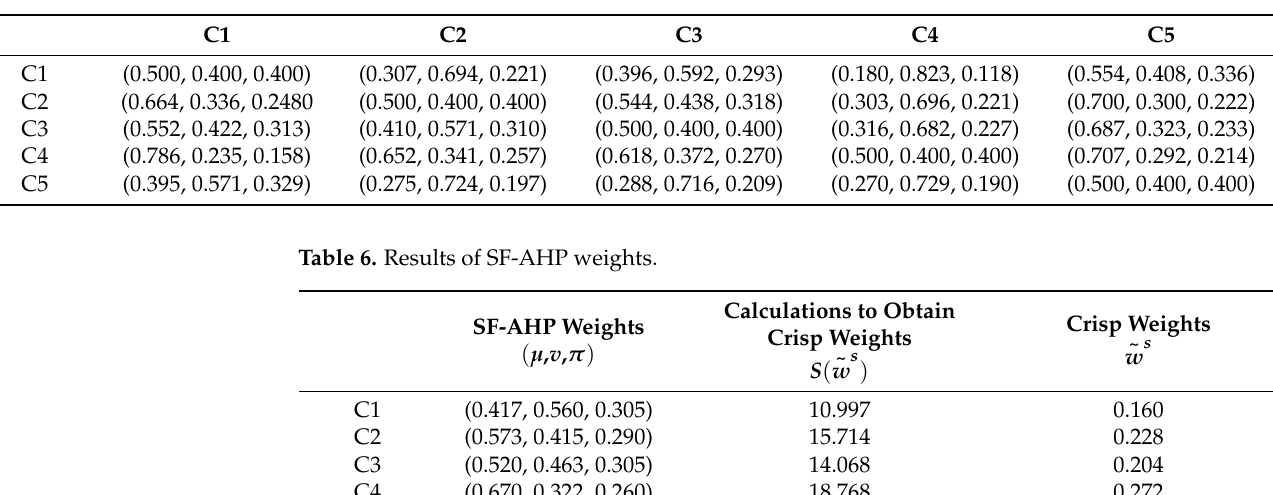
Table 5. Integrated spherical fuzzy comparison matrix.